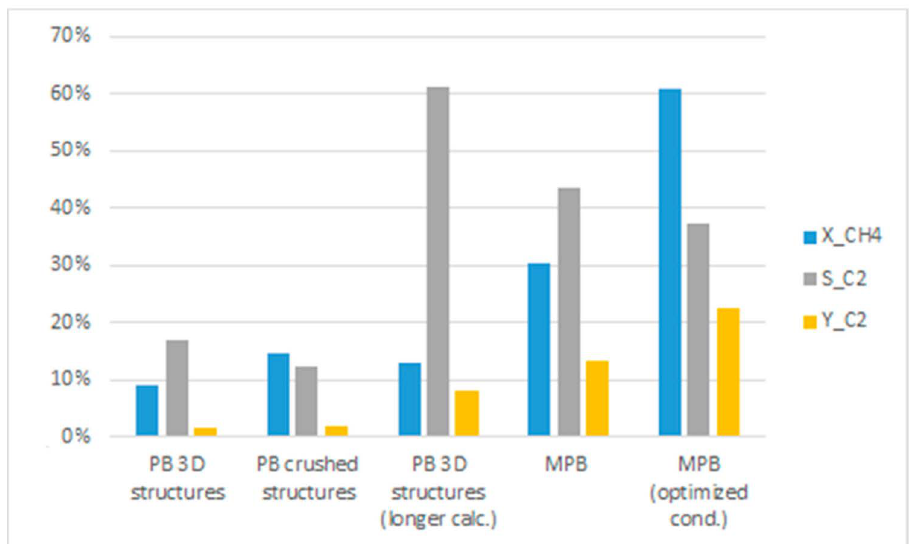
Figure 12. Summary plots of Mn–Na–W/SiO 2 catalyst performance in different reactor configurations under OCM conditions: (1) packed bed (PB) of 3D structures 4:1:5 (2) PB of crushed structures 4:1:5 (3) PB of 3D structures 4:1:5 (longer calcination) (4) Membrane packed bed (MPB) with powdered catalyst 4:1:5 (5) MPB with powdered catalyst 4:3:8:1:4 CH 4 :O 2 :N 2 + 30% CO 2 , total flow 200 mL/min (PB) and 300 mL/min (MPB), 840 ◦